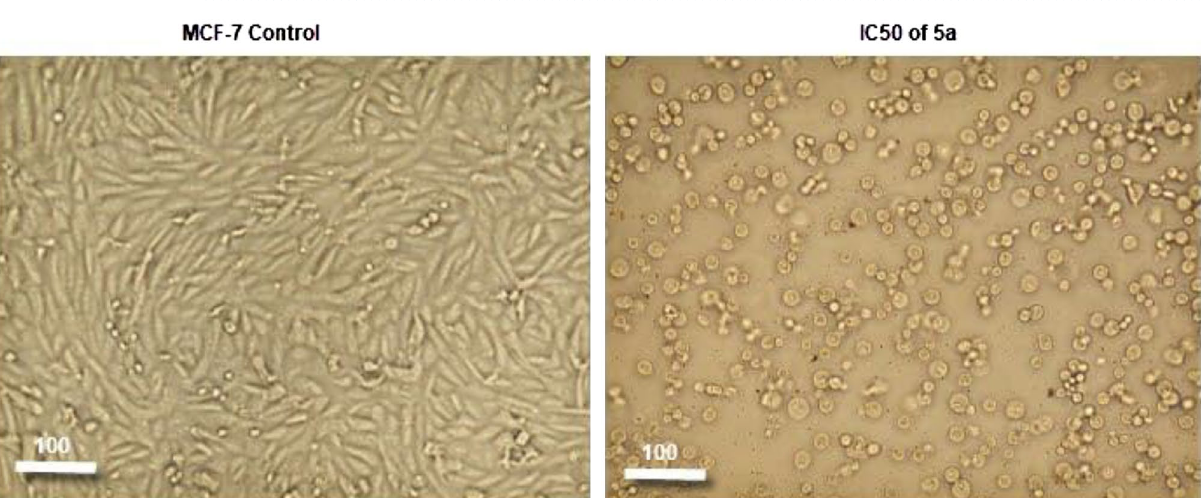
Figure 5. ( A ) Cytotoxicity of 5a against different cell lines. ( B ) Cytotoxicity of DOX against different cell lines. % Cell viability was plotted against concentrations to determine IC50. The values of IC50 are expressed as mean ± SE of three experiments done in triplets.